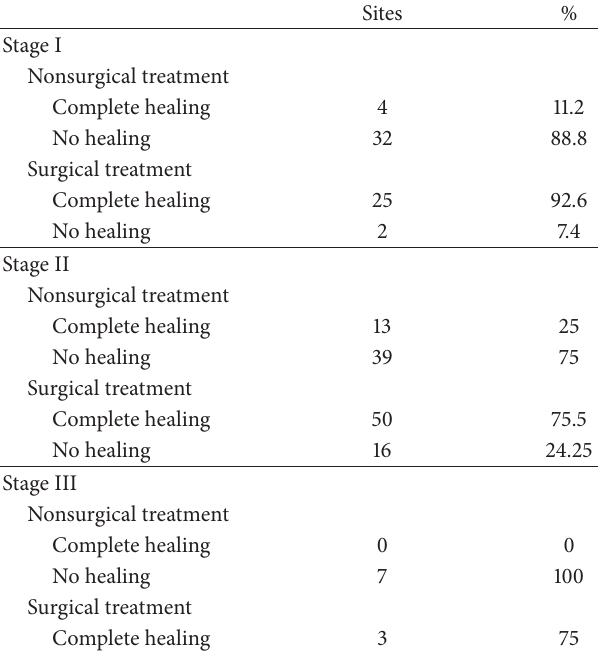
Table 7: Number and percentage of healed sites after BRONJ